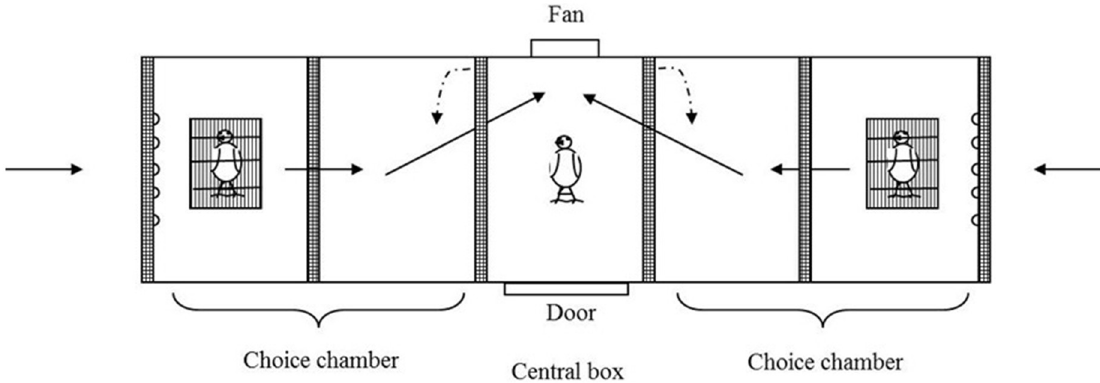
Fig 1. Olfactometry chamber. The solid arrows indicate the direction of air flow within the chamber, whereas the dashed lines indicate the direction of opening of the two doors connected to the two choice plastic chambers.